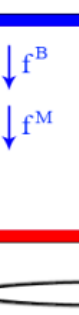
Energies 2021 , 14 , x FOR PEER REVIEW